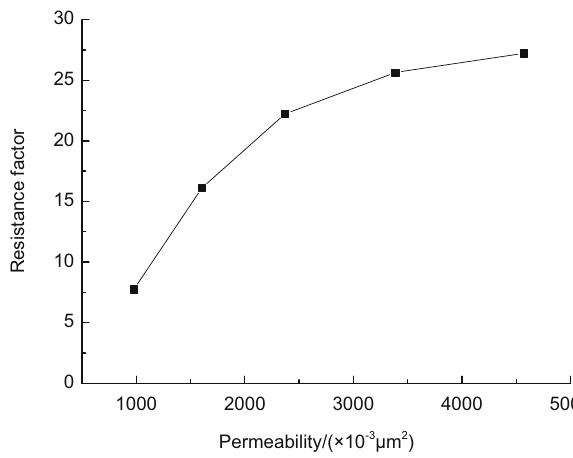
Figure 8: In fl uence of permeability on the foam resistance